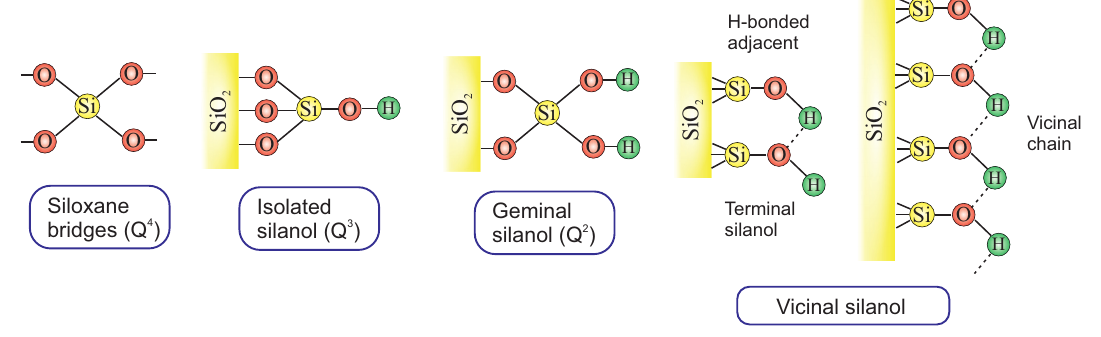
Figure 11. Various types of the surface of